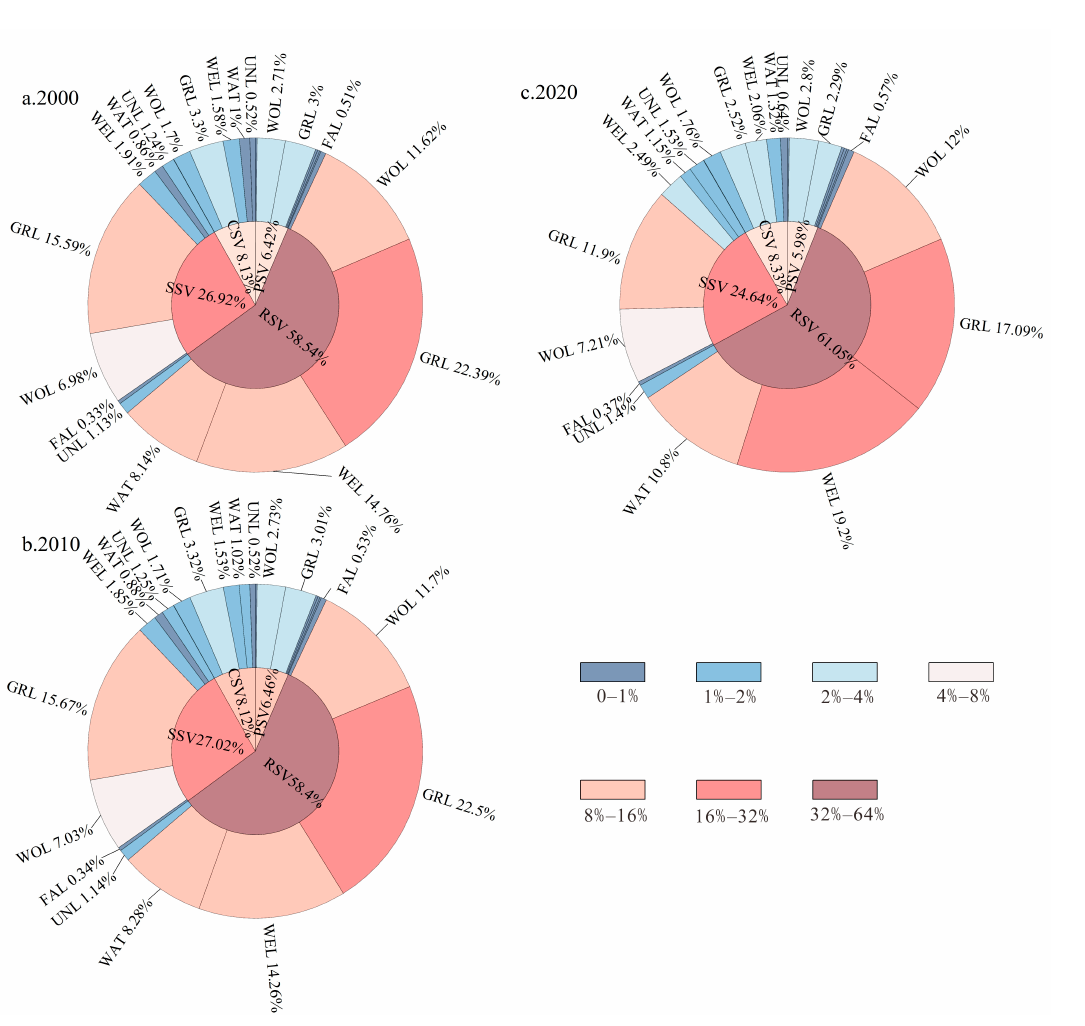
Figure 2. Share of land use type ecosystem services in total ecosystem services from 2000 to 2020. PSV: provision services values, RSV: regulate services values, SSV: support services values, CSV: cultural services values, FAL: farmland, WOL: woodland, GRL: grassland, WAT: water bodies, WEL: wetland, COL: construction land, UNL: unused land.